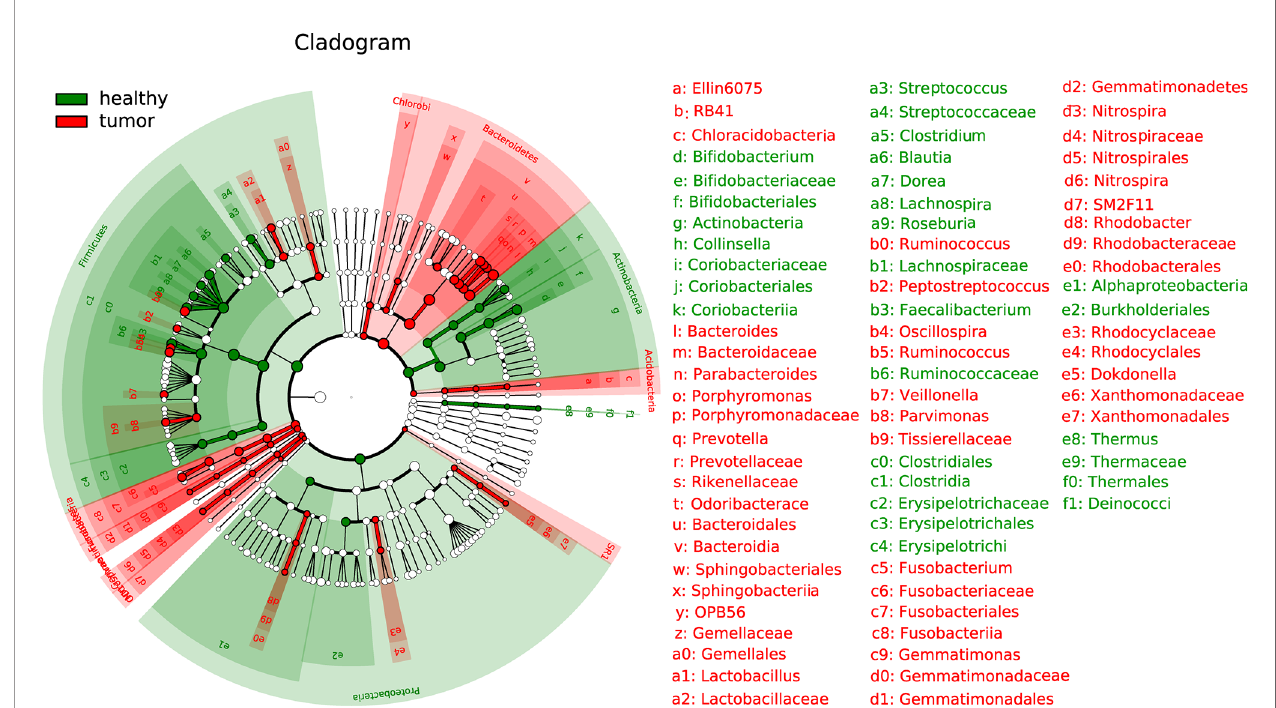
FIGURE 2 | Linear discriminant analysis effect size (LEfSe) analysis of gut microbiota composition between two